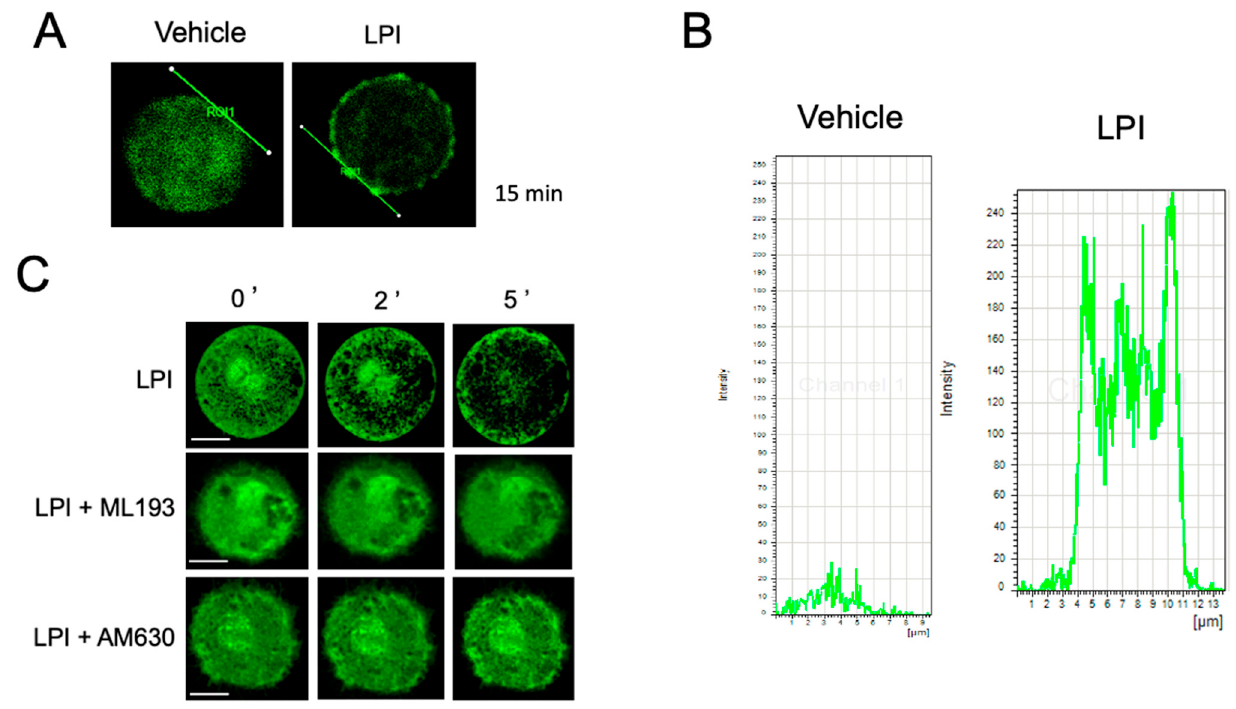
Figure 3. LPI induces actin cytoskeletal rearrangements and actin ring depolymerization in MCs. EGFP-BMMCs were incubated under distinct conditions before being processed for confocal microscopy. Panels ( A , B ): representative image of EGFP-BMMCs treated for 15 min with vehicle or LPI (1 µ M). A line was traced on the edge of the cell and fluorescence values were obtained along the line to obtain representative graphs. Panel ( C ): EGFP-BMMCs were incubated in the presence of vehicle or LPI (1 µ M) directly in a plate placed at the confocal microscope (Materials and Methods section). Images were taken every second for 300 s and representative images of a cell, obtained at time zero and distinct times after stimulation, are shown. When needed, cells were treated for 15 min with antagonists ML193 (100 nM) or AM630 (100 nM) before LPI addition. Data are representative of at least 10 cells analyzed under each condition, utilizing at least three independent cell cultures.